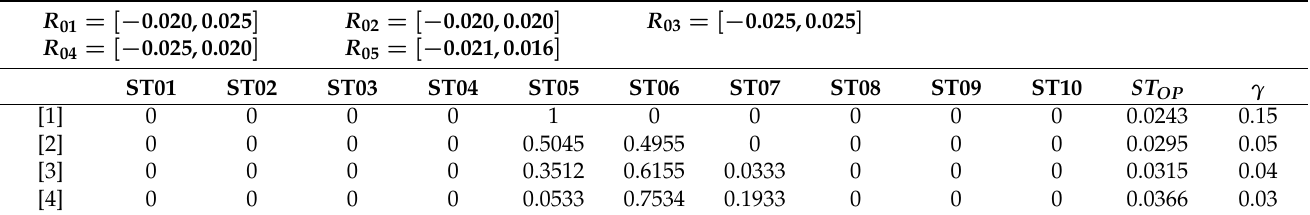
Table 6. Portfolio, Model 2 with different R 0 j for different j = 1, · · · ,5 R 01 = [ − 0.020,0.025 ]